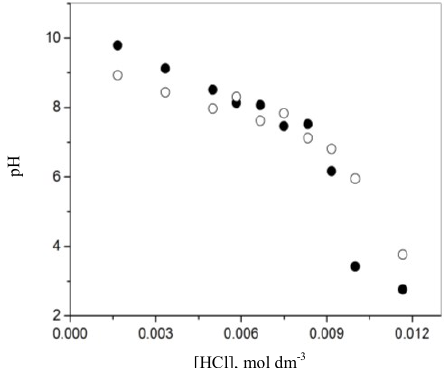
Figure 1. Equilibrium titration curve of linolenic acid (●) 12.5 mM and PEGylated linolenic acid (○) 12.5 mM at 28 °C as a function concentration